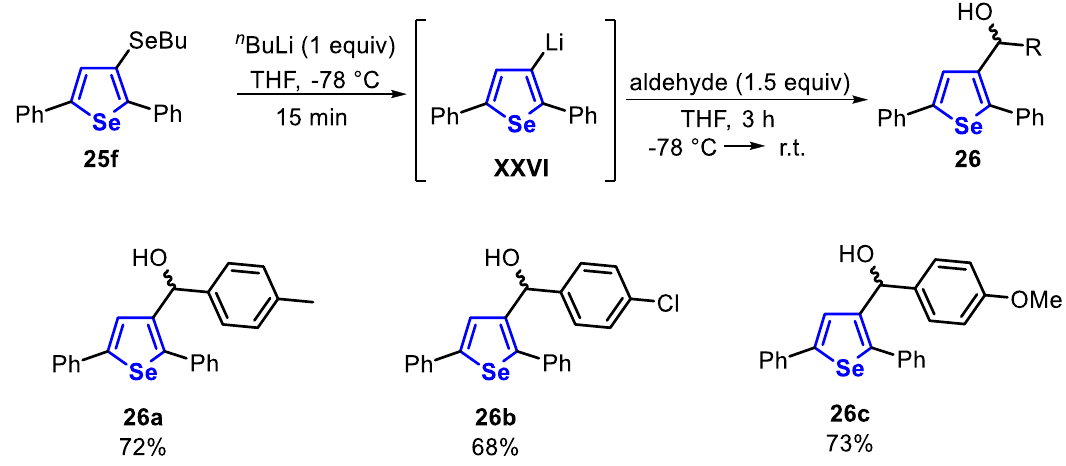
Scheme 22. Reactions of 3-lithio-selenophene with aldehydes.